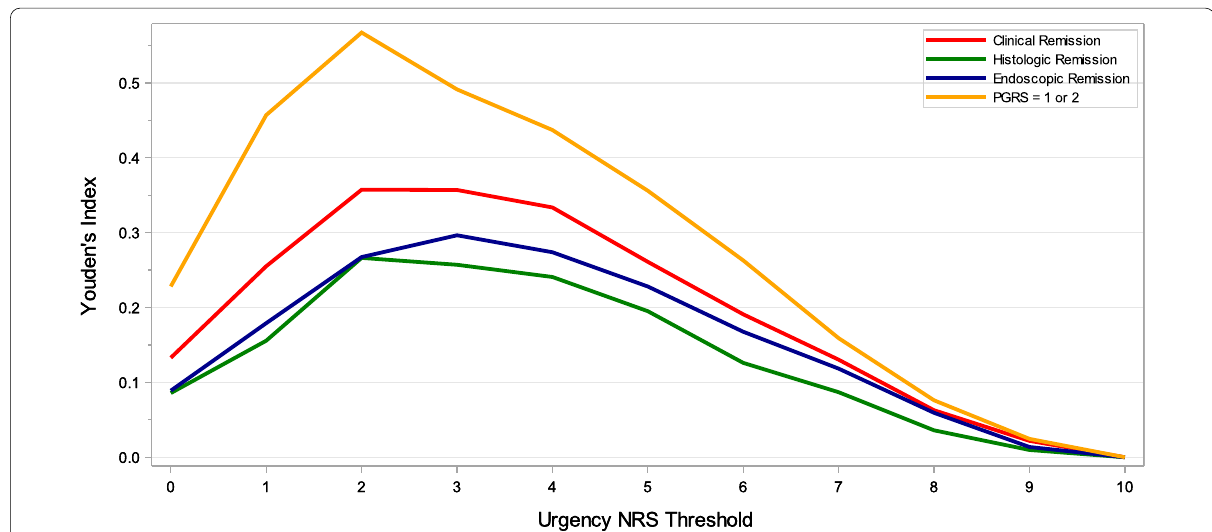
Fig. 4 Youden’s Index from an anchor-based analysis of remission on the Urgency NRS at week 12. Clinical remission was defined as a Mayo stool frequency subscore of 0, or 1 with a 1-point decrease from baseline; a Mayo rectal bleeding subscore of 0; and a Mayo endoscopic subscore ≥ of 0 or 1 (excluding friability). Histologic remission was defined as a Geboes histologic score of 2b. Endoscopic remission was defined as a Mayo endoscopic subscore of 0 or 1 (excluding